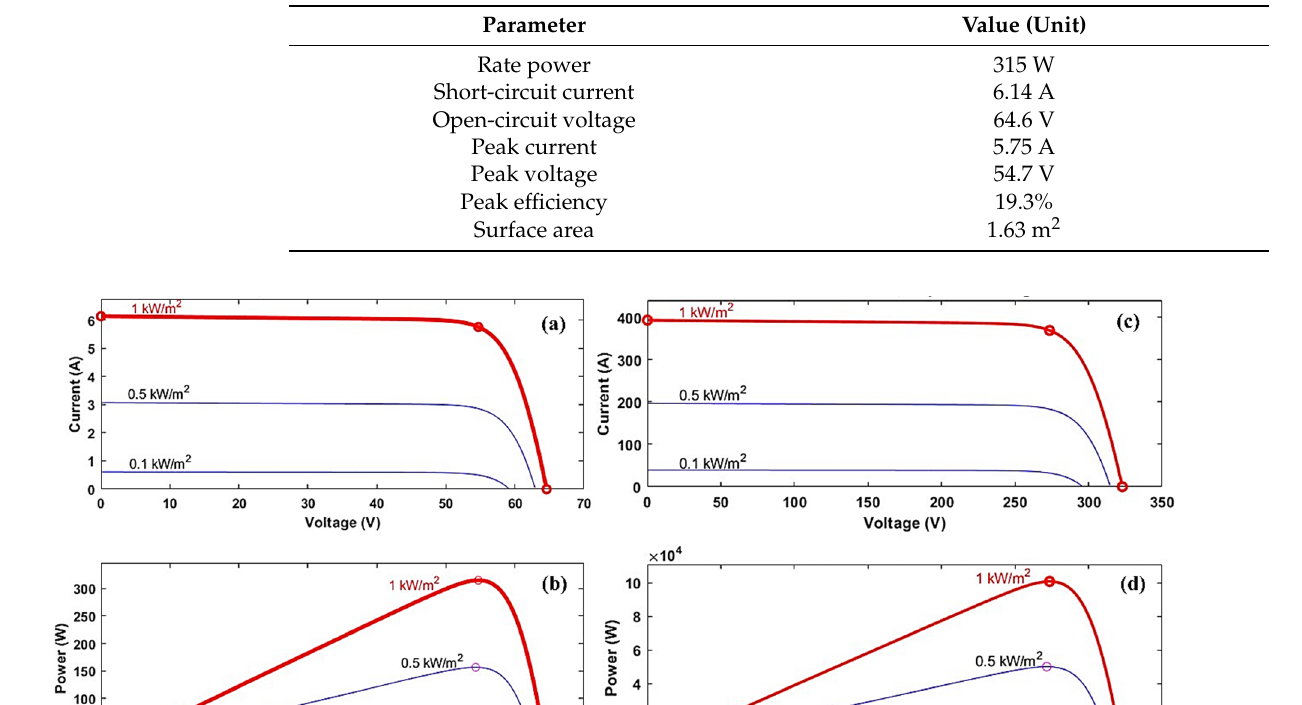
Table 1. Technical specifications of the PV module used in array modeling.